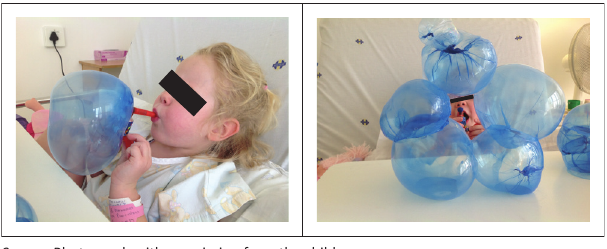
FIGURE 5: The author’s then 4-year old daughter doing ‘fun’ positive expiratory pressure therapy following Nissen’s funduplication surgery and postoperative pulmonary